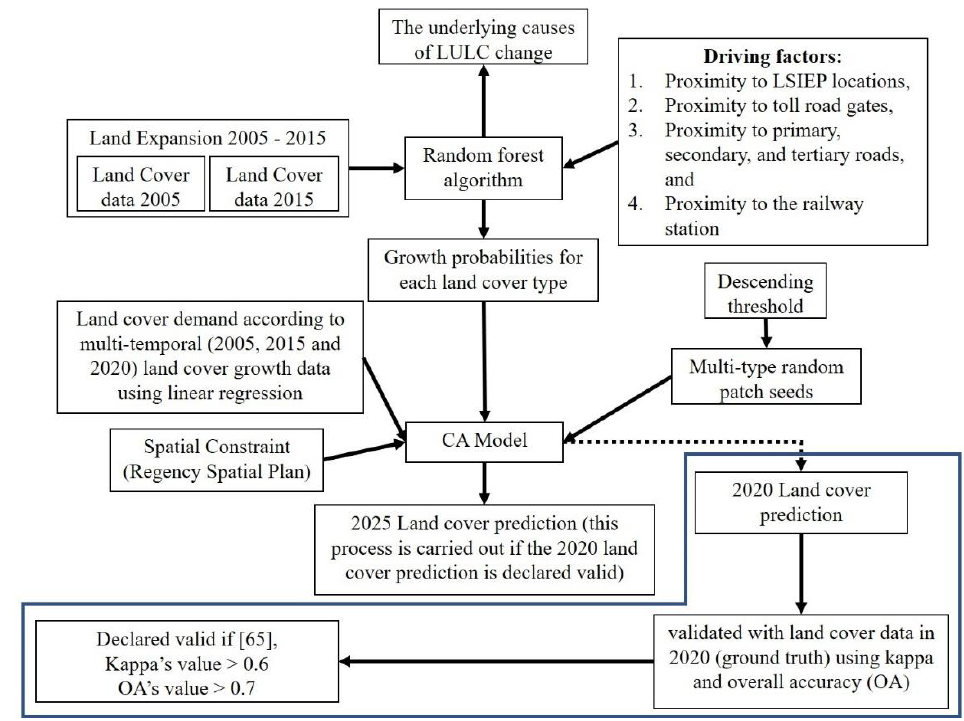
Figure 5. The framework of landcover prediction, modified from Liang et al. [36].